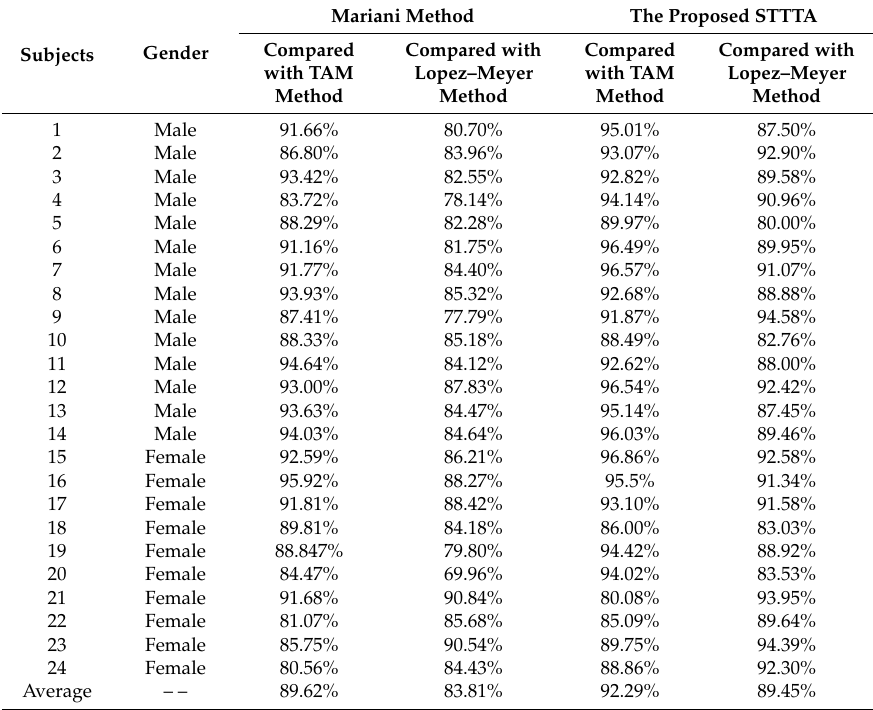
Table 2. Comparative reliability results for the proposed method.